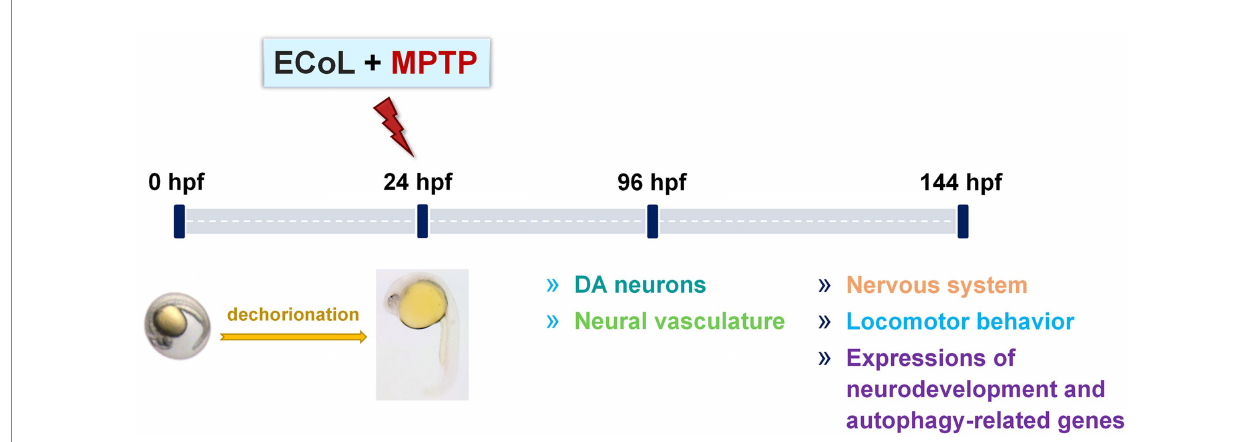
FIGURE 1 Overview of the experimental workflow and examined indices. Larvae at 24 hpf were dechorionated and co-exposed to 50 μ M MPTP and ECoL (10, 14, and 18 μ g/mL, respectively). The developmental detection of DA neurons and neural vasculature was conducted at 96 hpf. At 144 hpf, treated zebrafish were subjected to evaluations of nervous system, locomotor behavior, and expressions of genes related to neurodevelopment and